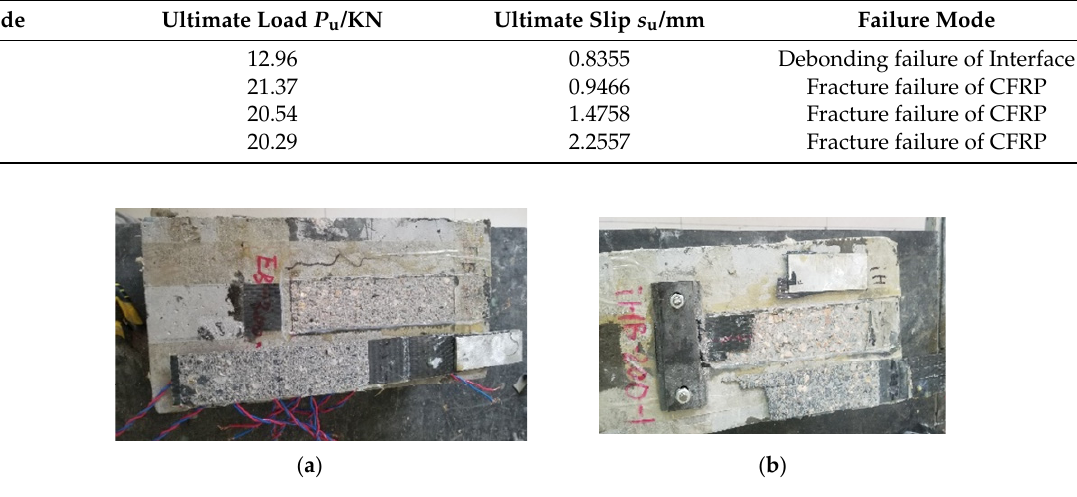
Figure 8. Failure of specimens: ( a ) EB-200-0; ( b ) SLHB-200-15.